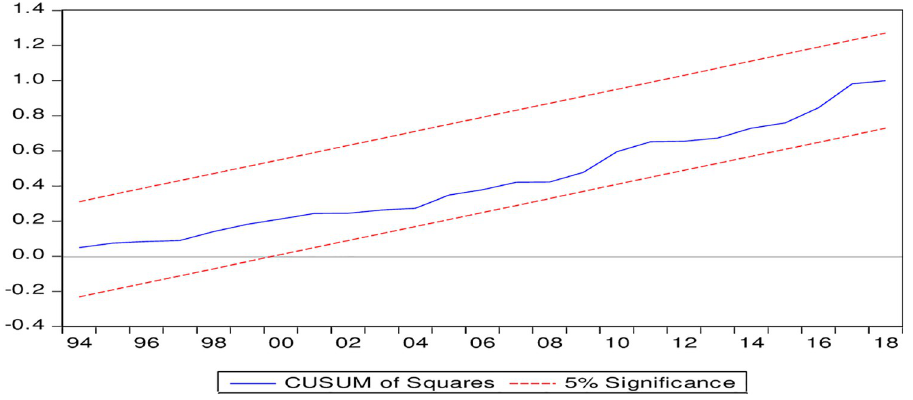
Fig 4. Plot of cumulative sum of squares of recursive